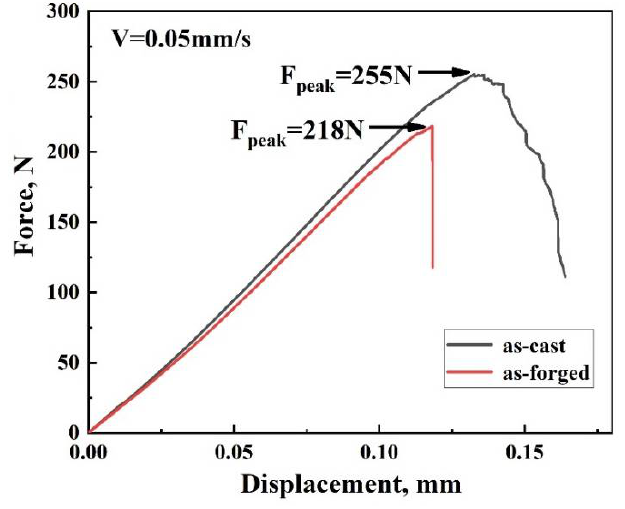
Figure 8. Load-displacement curves of the Ti-43Al-2Cr-1.5Mn-0.1Y alloy in different